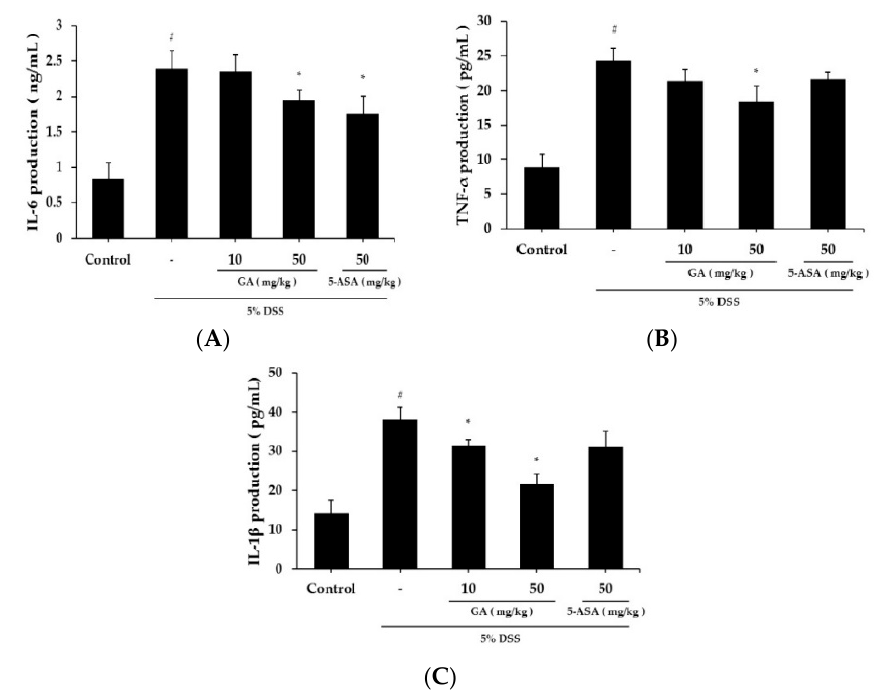
Figure 3. Effects of inflammatory cytokines levels in DSS-induced UC. ( A ) IL-6 production in mouse serum at day 10; ( B ) TNF- α production in mouse serum at day 10; ( C ) IL-1 β production in mouse serum at day 10. Values represent mean ± S.E.M. ( n = 6). Data were analyzed by Student’s t -test ( # p < 0.05 vs. control and * p < 0.05 vs. DSS alone).